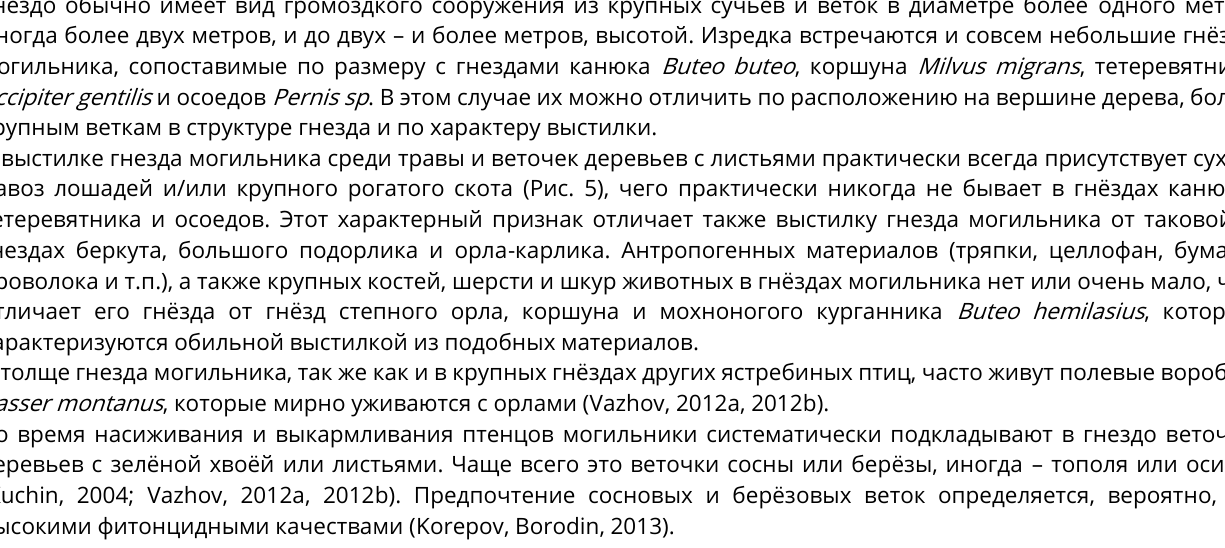
Рис. 2. Типичные для Алтая гнёзда могильника на лиственнице в межгорной котловине в Республике Алтай (слева) и на сосне, на опушке ленточного бора, в Алтайском крае (справа). 08 июня 2009 г. и 17 мая 2019 г. Фото С.В.